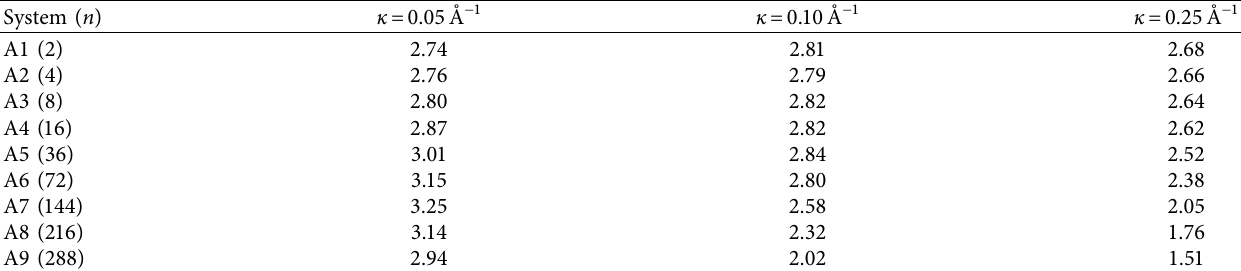
Table 6: Water diffusion coefficients (10 − 9 m 2 /s) at 25 ° C employing a velocity Verlet algorithm, where n is the number of (Na + +Cl − ) ions.